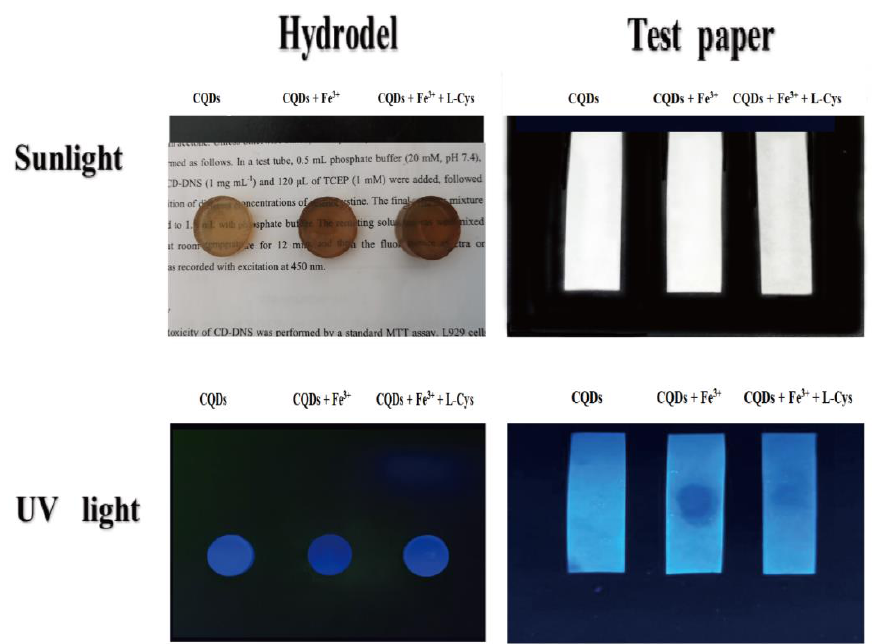
Figure 5. Photographs of the cellulose/CQD composite hydrogels and CQD-based test papers for the colorimetric and fluorescent detection of L-Cys under irradiation of sunlight and UV light (365 nm).